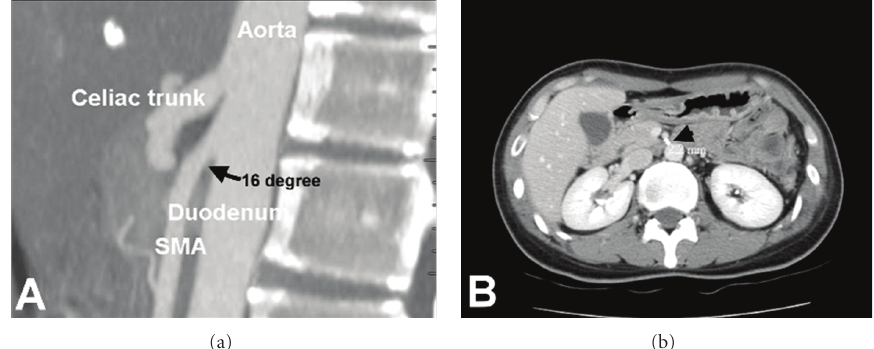
Figure 2: A diagnostic criteria of superior mesenteric artery syndrome are based on the aortomesenteric angle less than 25 ◦ (a, arrow) or aortomesenteric distance less than 8mm (b,